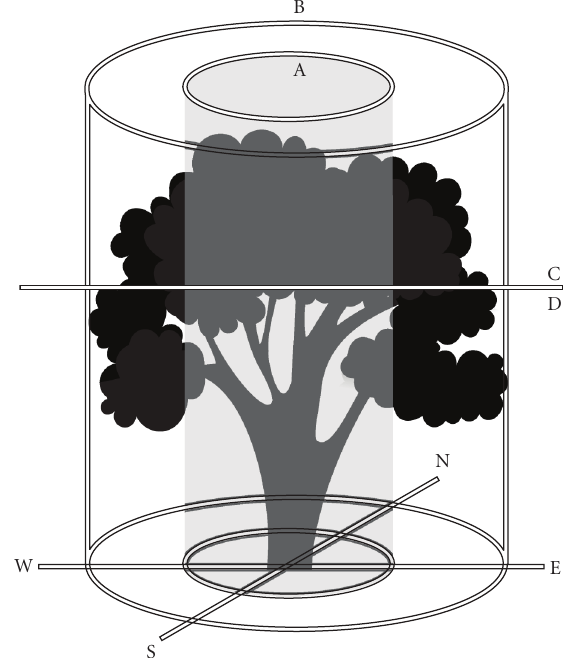
Figure 1: Division of the guava trees to determine the damage pattern of Conotrachelus dimidiatus . Internal zone (A) external zone (B). Upper zone (C) and lower zone (D). Cardinal points: North (N), South (S), East (E), and West (W).